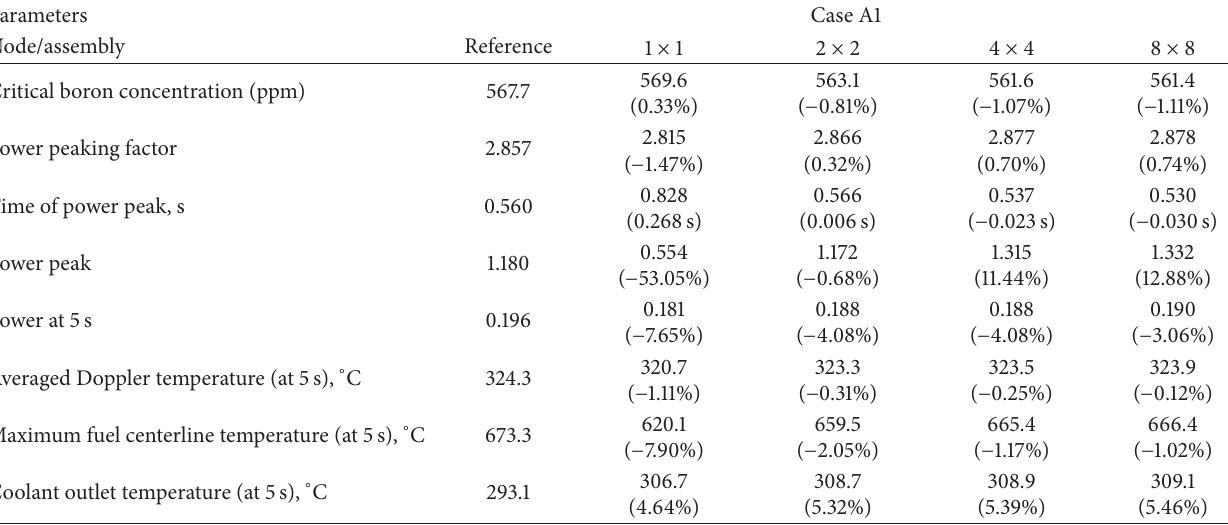
Table 1: Sensitivity analysis results in radial node number per assembly for case A1.